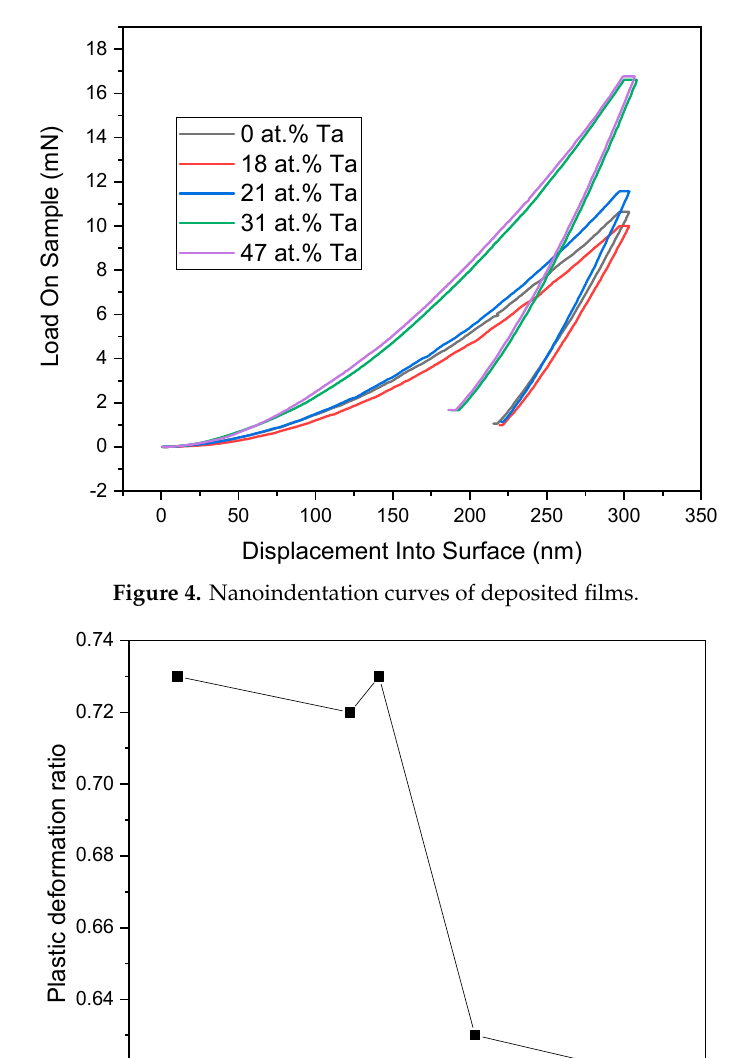
Figure 5. Evolution of plastic deformation ratio as a function of tantalum content.